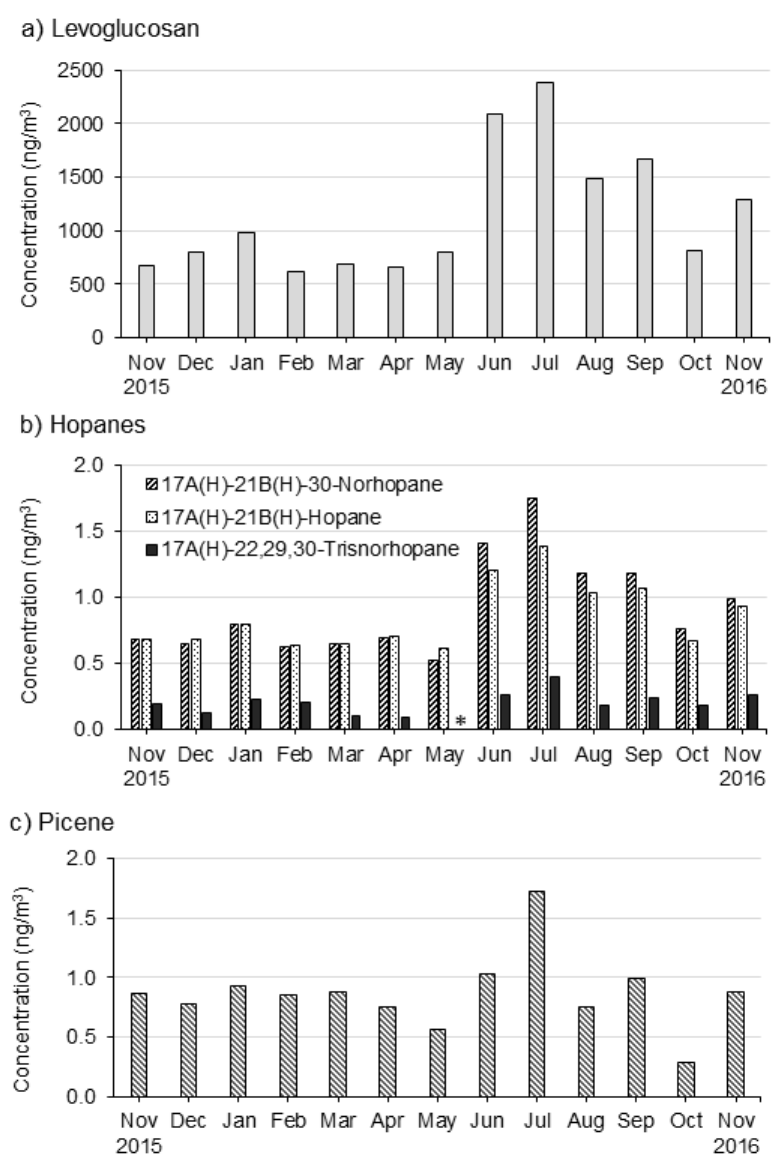
Figure 1. Monthly trends in concentrations of selected organic tracers used as fitting species in the chemical mass balance model: ( a ) Levoglucosan, ( b ) Hopanes, and ( c ) Picene. * indicates below detection.